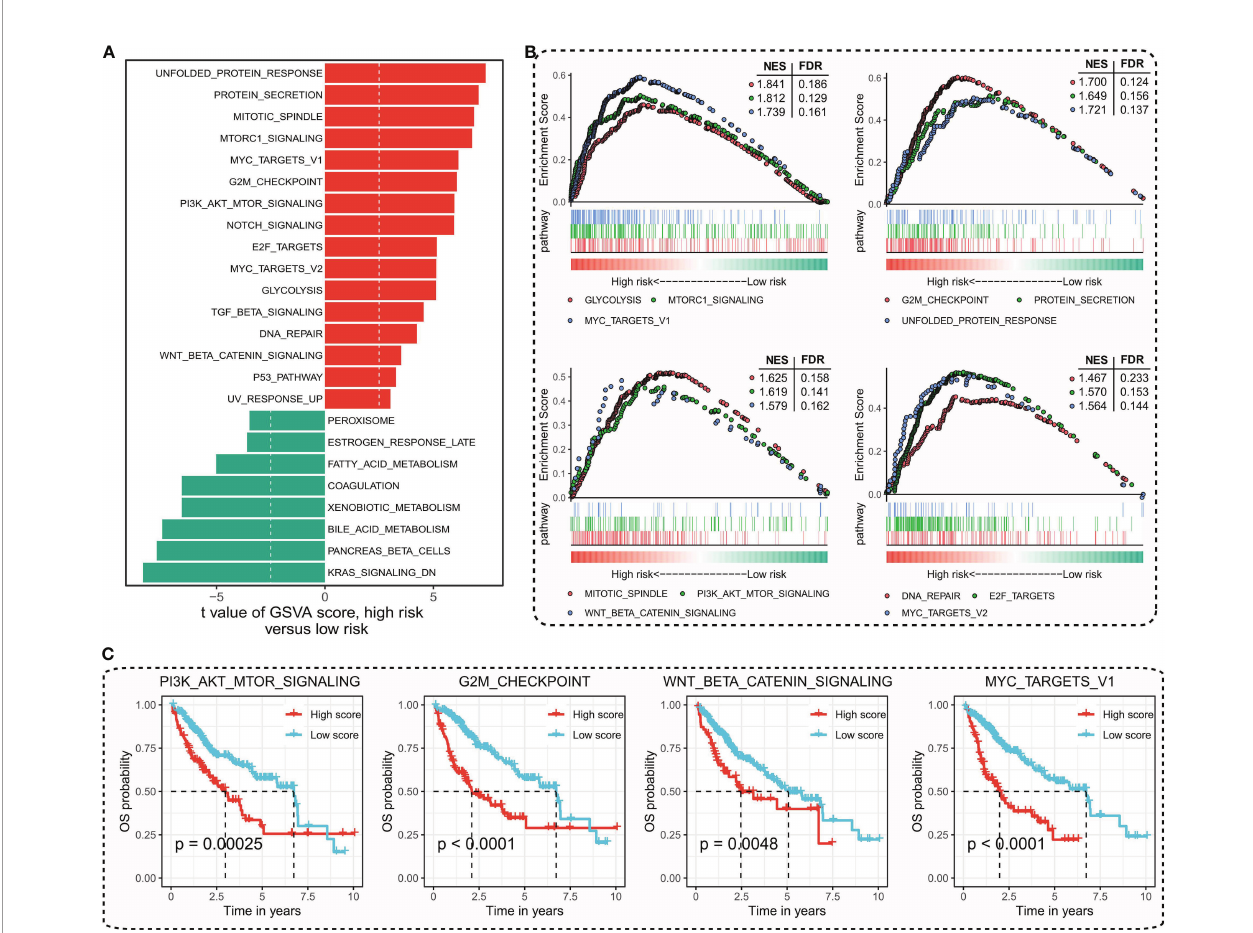
FIGURE 7 | Determination of the distinct hallmark pathways of the TIPRGPI low- and high-risk groups. (A) Differences in cancer hallmark pathway activities between the high- and low-risk groups scored by GSVA. (B) The GSEA results for the 12 overlapping upregulated hallmark pathways in terms of the TIPRGPI risk groups. (C) Kaplan-Meier survival plots showing the signi fi cant correlations between the OS and GSVA scores of typical oncogenic hallmark pathways. GSVA, gene set variation analysis. GSEA, gene set enrichment